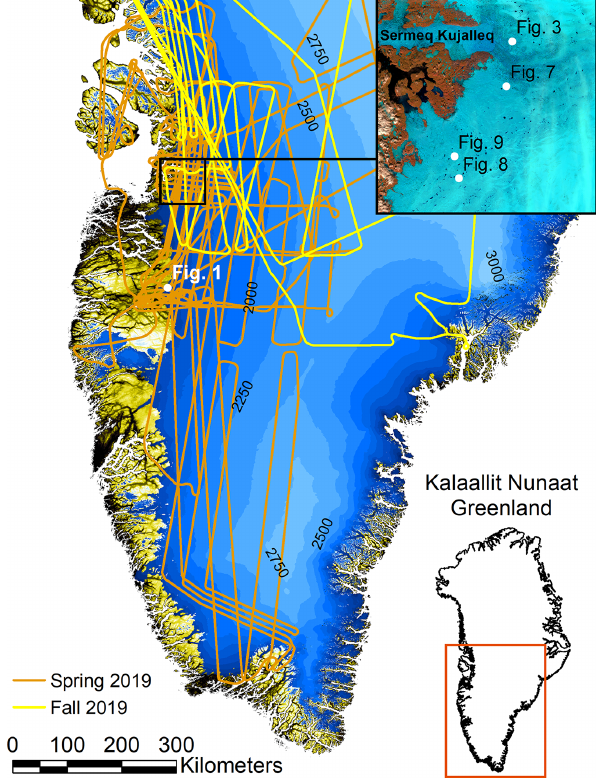
Figure 2. Location map with spring and fall 2019 flight lines. Ice surface elevation is shown in blue with a 250m elevation con- tour interval. Topography and ice mask data are from the Green- land Ice Mapping Project (GIMP) digital elevation model (Howat et al., 2014; Morlighem, 2021). Inset map over the Sermeq Kujalleq (Jakobshavn Isbræ) region showing figure locations is a Sentinel-2A false color image (bands 11, 8A, and 4) from 17 May